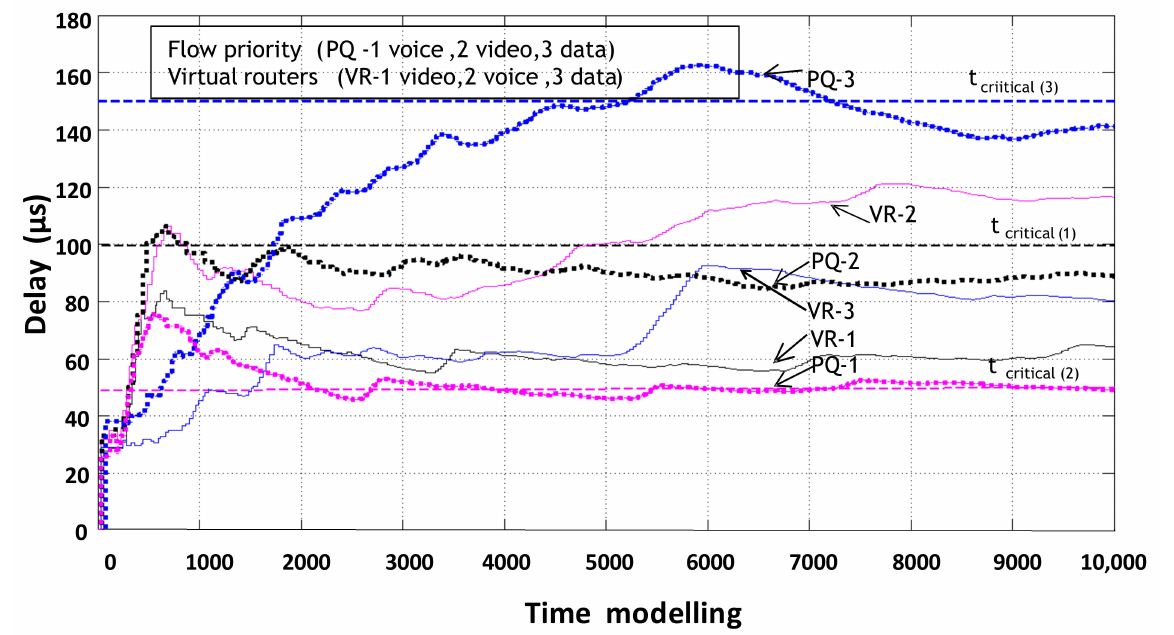
Figure 16. Comparison of packet delay times in a router with prioritized service and with static virtualization of network device resources.